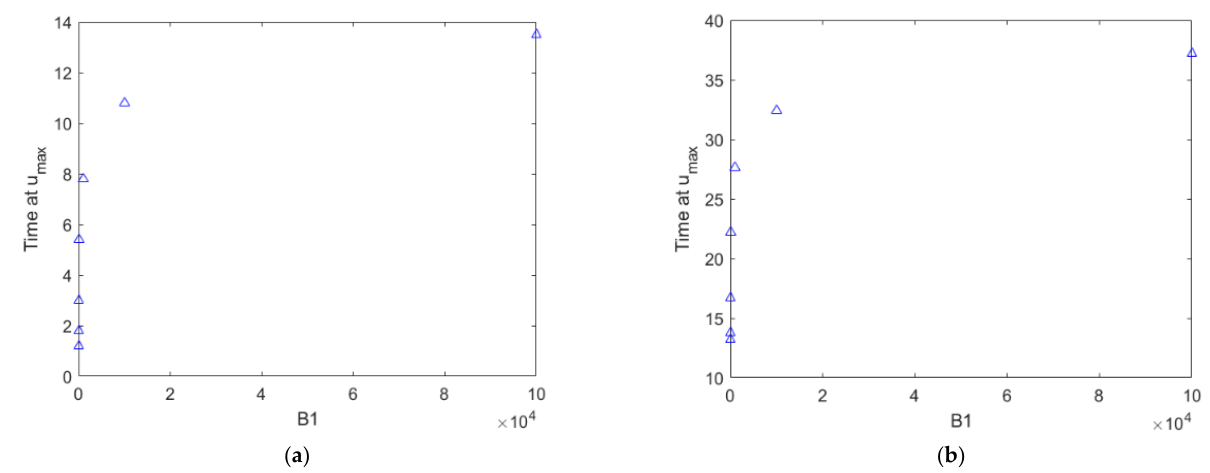
Figure 13. The t max time against parameters B 1 for the application of Policy 2. ( a ) Control effort u 1 ; ( b ) Control effort u 2 . Figure 13. The max t time against parameters 1 B for the application of Policy 2. ( a ) Control effort 1 u ; ( b ) Control effort 2 u .